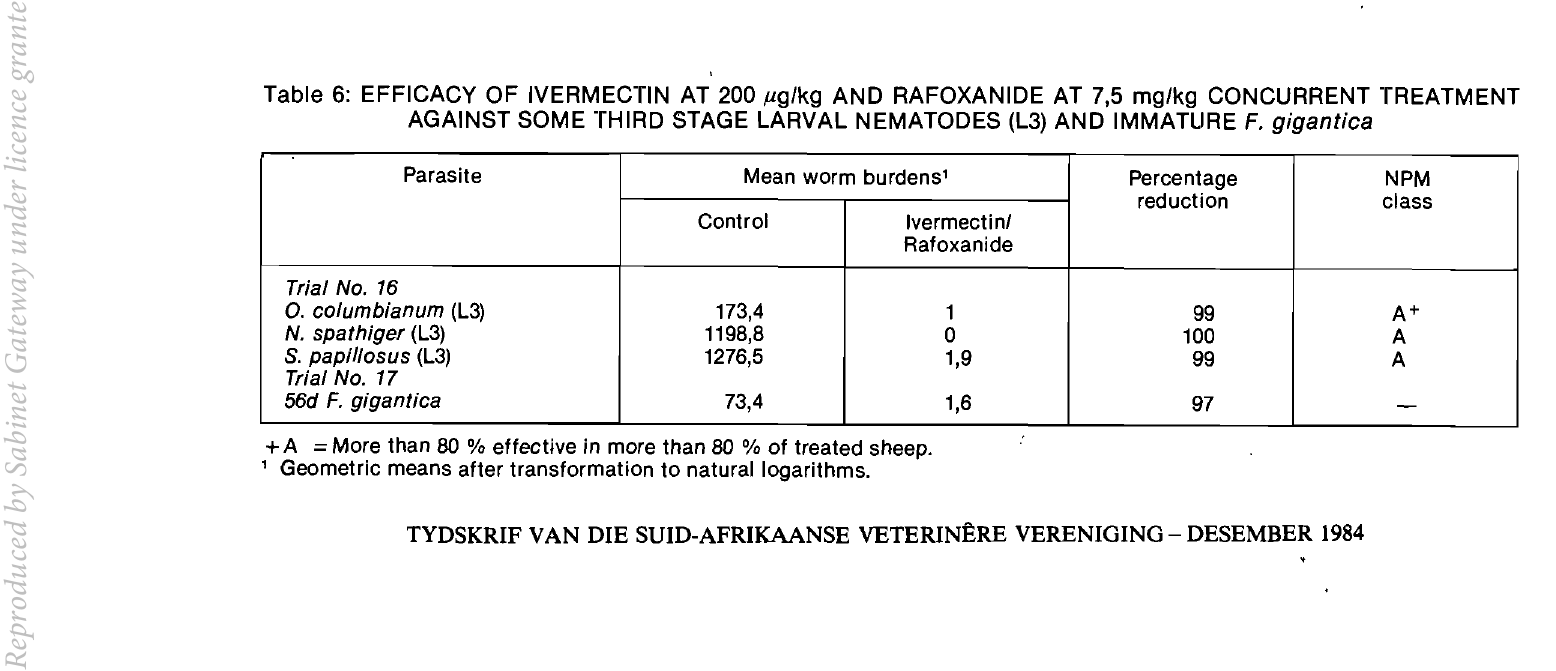
Table 6: EFFICACY OF IVERMECTIN AT 200 ,ug/kg AND RAFOXANIDE AT 7,5 mg/kg CONCURRENT TREATMENT AGAINST SOME THIRD STAGE LARVAL NEMATODES (L3) AND IMMATURE F.